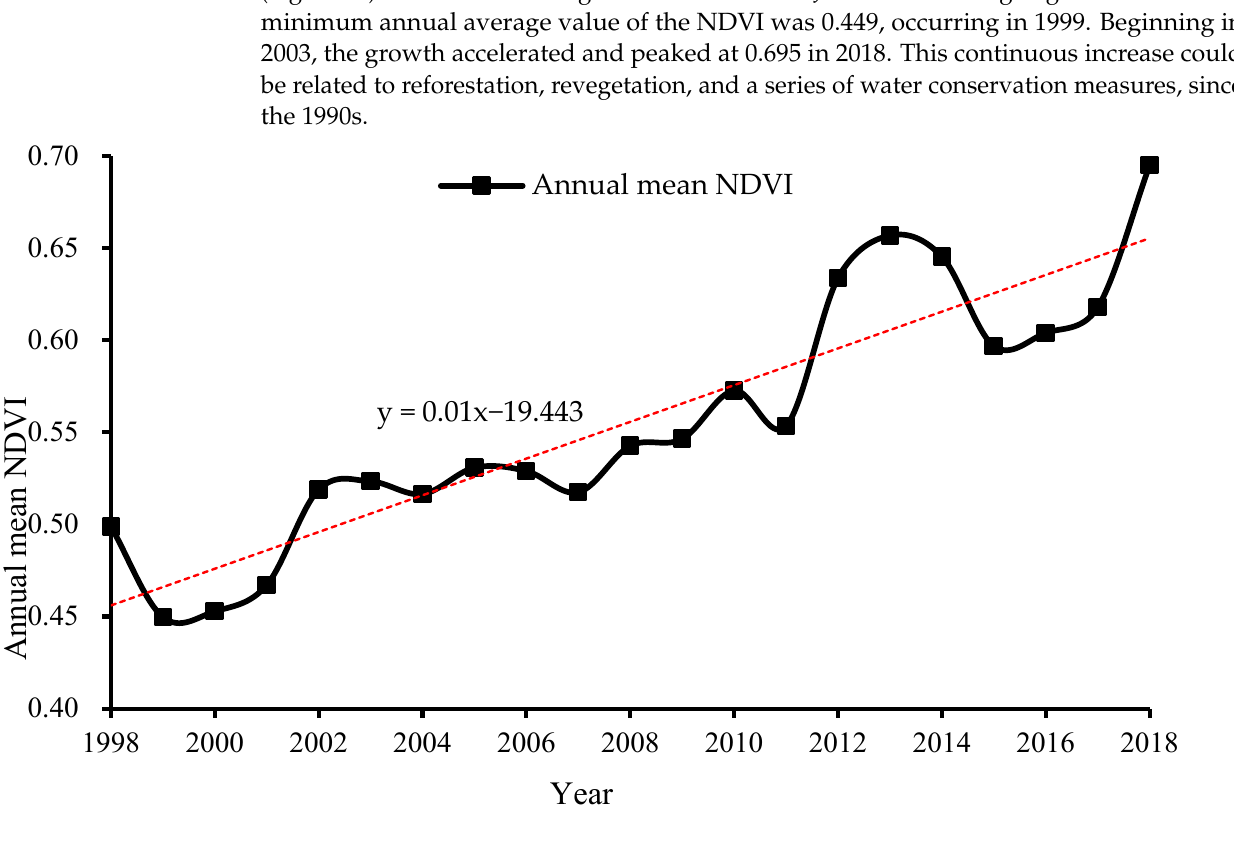
Figure 10. NDVI changes in the JRB, from 1998 to 2018.